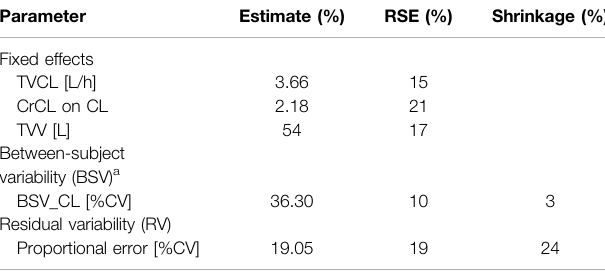
TABLE 2 | Population pharmacokinetic parameter estimates from the fi nal